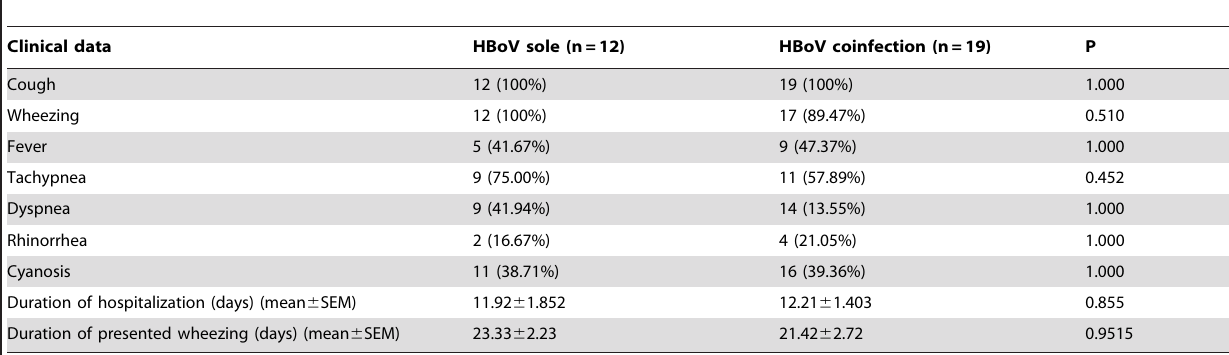
Table 3. Clinical characteristic of children who had HBoV detection with or without detection of other viruses.